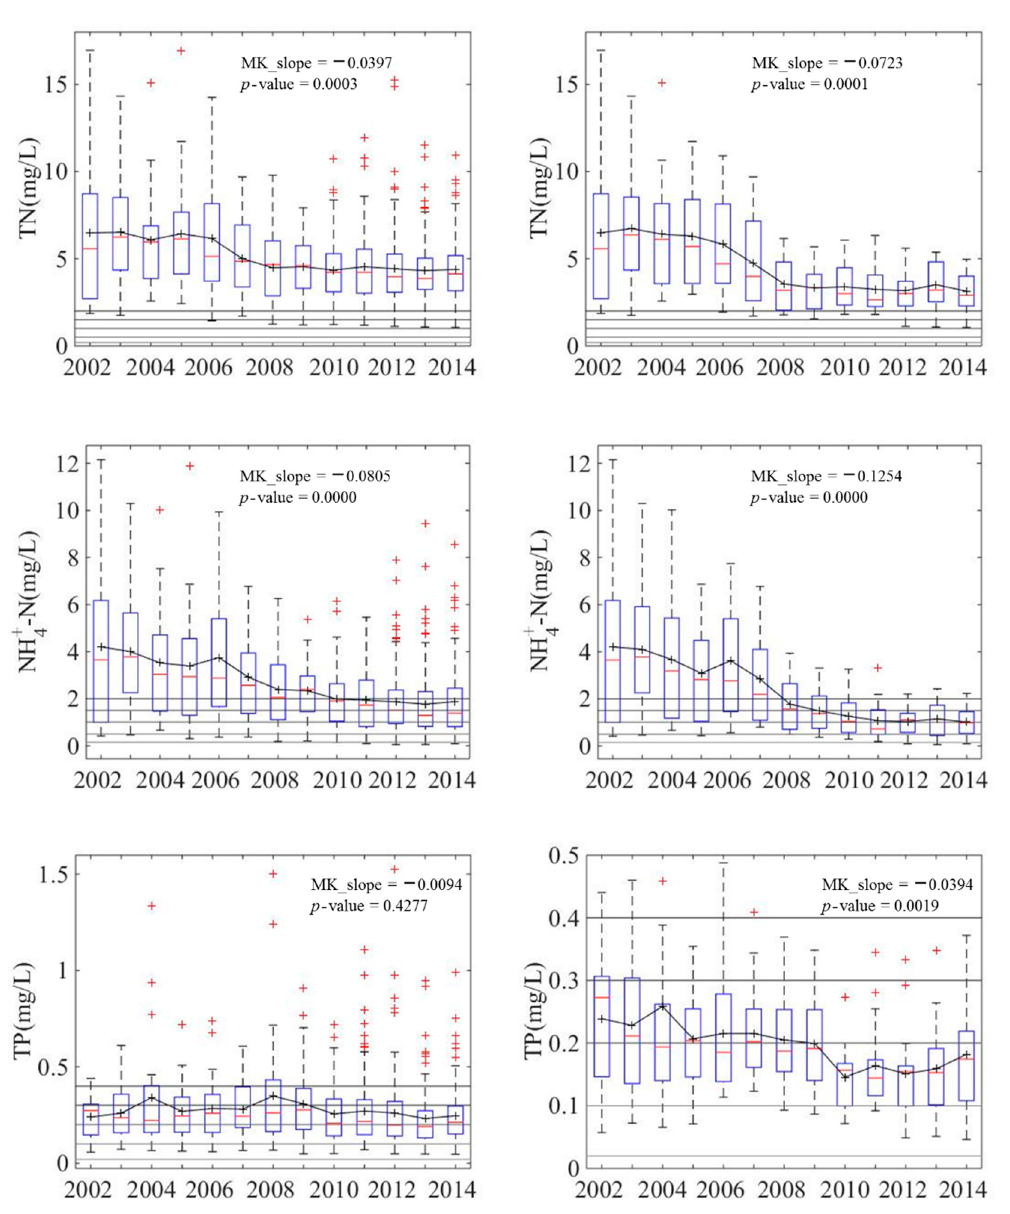
Figure 3. Variations in the mean values and boxplots of the annual average concentrations of TN, NH 4+ -N and TP from 2002 to 2014 based on different levels of the GB3838-2002 standards (lines of the Class V standard to the Class I standard gradually change from black to 50% gray; the curves represent the mean values, the black ‘+’ symbols represent the mean values of the data, the red lines represent the median values of the data, the edges of the boxes are the 25th and 75th percentiles, the whiskers extend to the most extreme data points that were not considered outliers by the algorithm, and the outliers are plotted individually as red ‘+’ symbols; the boxplots in the left column are based on all sites, and plots in the right column are based on 16 sites). The trends of mean values are estimated using MK test, as shown as the texts of MK_slope and p _value in all sub figures.